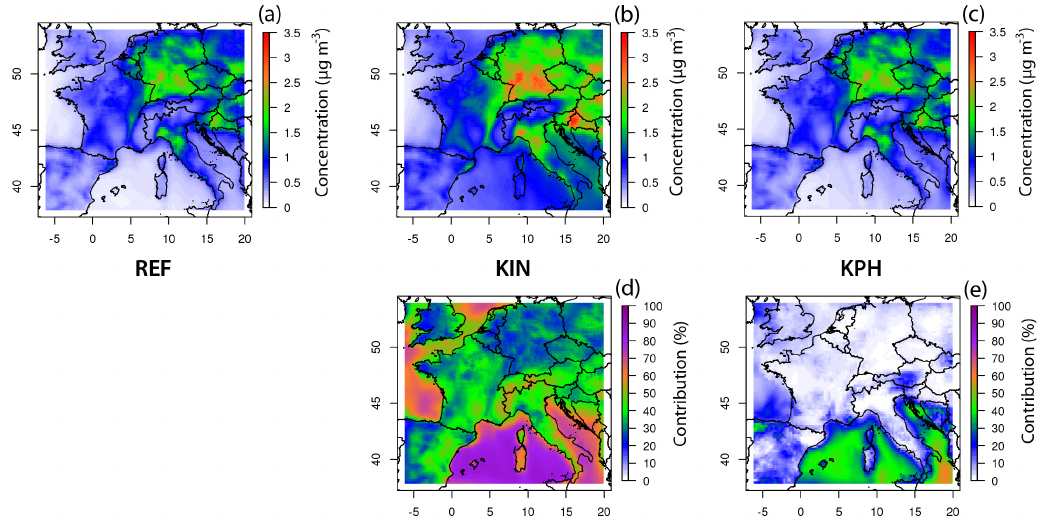
Figure 8. Modeled average BSOA concentration from monoterpenes simulated in the reference case (left), from the KIN approach (center) and from the KPH approach in the metastable mode (right) for the period 20 July–3 August 2006. Lower graph: contribution of oligomers to BSOA terp .